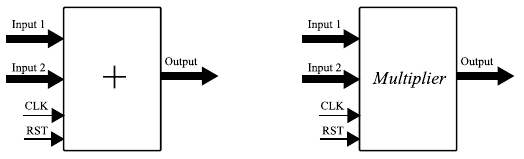
Figure 8. VHDL block descriptions of the adder and multiplier including clock and reset pins. CLK, clock; RST, reset.